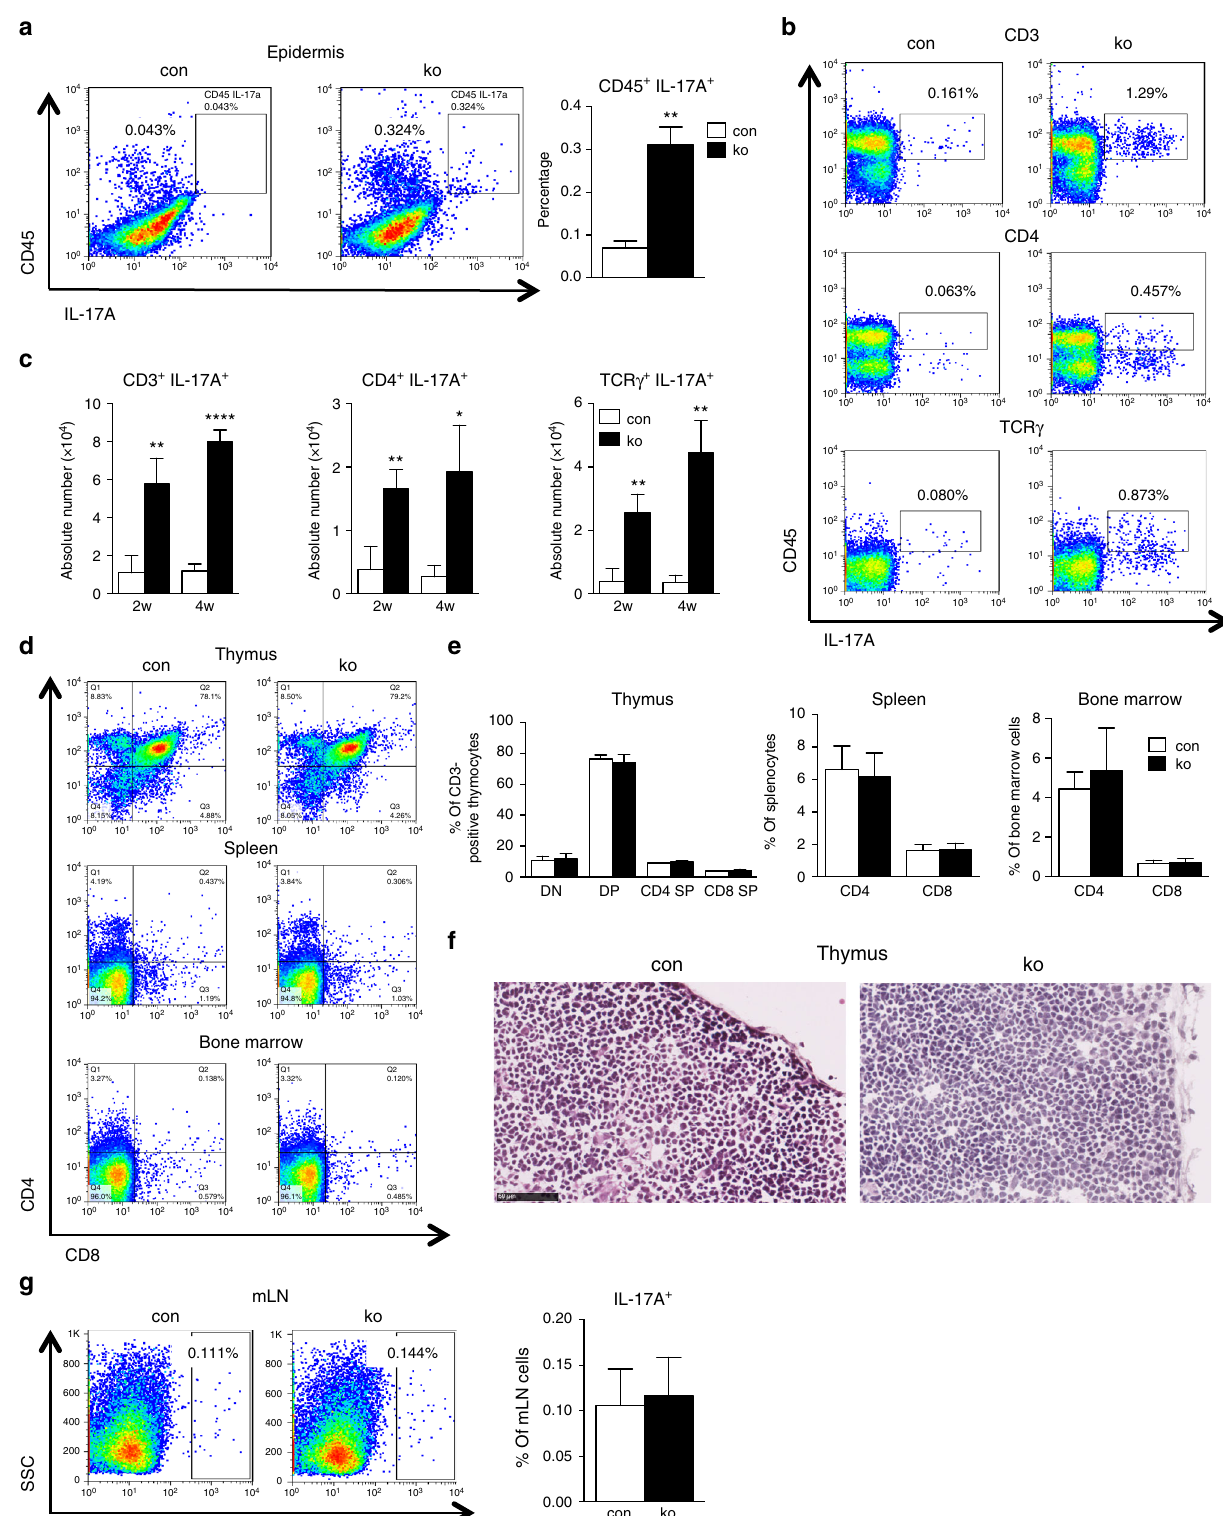
Fig. 4 Increased IL-17A-producing cells in N-WASP ko mice. a Representative and quanti fi cation of intracellular FACS analysis of IL-17A + cells in epidermis ( n : 3/3, mean ± SD, two-tailed unpaired t -test). b , c Representative and quanti fi cation of intracellular FACS analysis of IL-17A + cells in iLN ( n : 3/3, mean ± SD, two-tailed unpaired t -test). d , e Representative and quanti fi cation of CD4, CD8 distribution in thymus, spleen, and bone marrow from 9-day-old con and ko mice ( n : 3/3, two-tailed unpaired t -test). f Representative H&E staining of thymus from 9-day-old con and ko mice ( n : 3/3). Scale bar: 50 µ m. g Representative and quanti fi cation of intracellular FACS analysis of IL-17A + cells in mLN ( n : 6/6, mean ± SD, two-tailed unpaired t- test; * p ≤ = 0.05; ** p ≤ = 0.01; **** p ≤ =